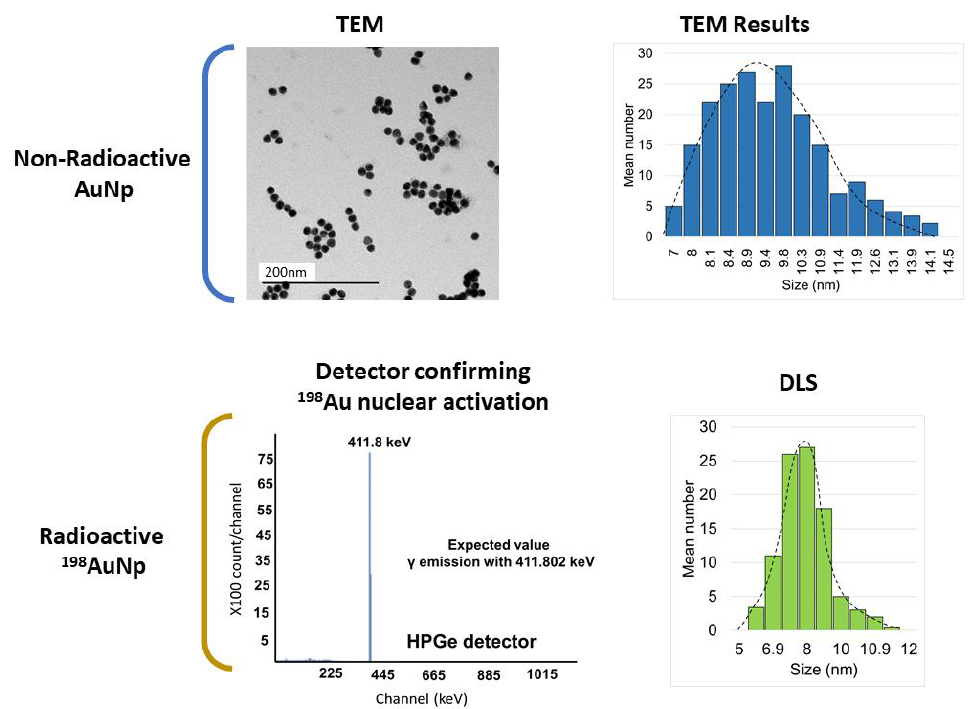
Figure 2. TEM results for the non-radioactive product (average size: 11.0 nm; median: 9.4 nm; standard deviation: 2.3 nm). DLS and HPGe detector results for the radioactive AuNPs (average size: 8.7 nm; median: 9.2 nm; standard deviation: 2.0 nm).